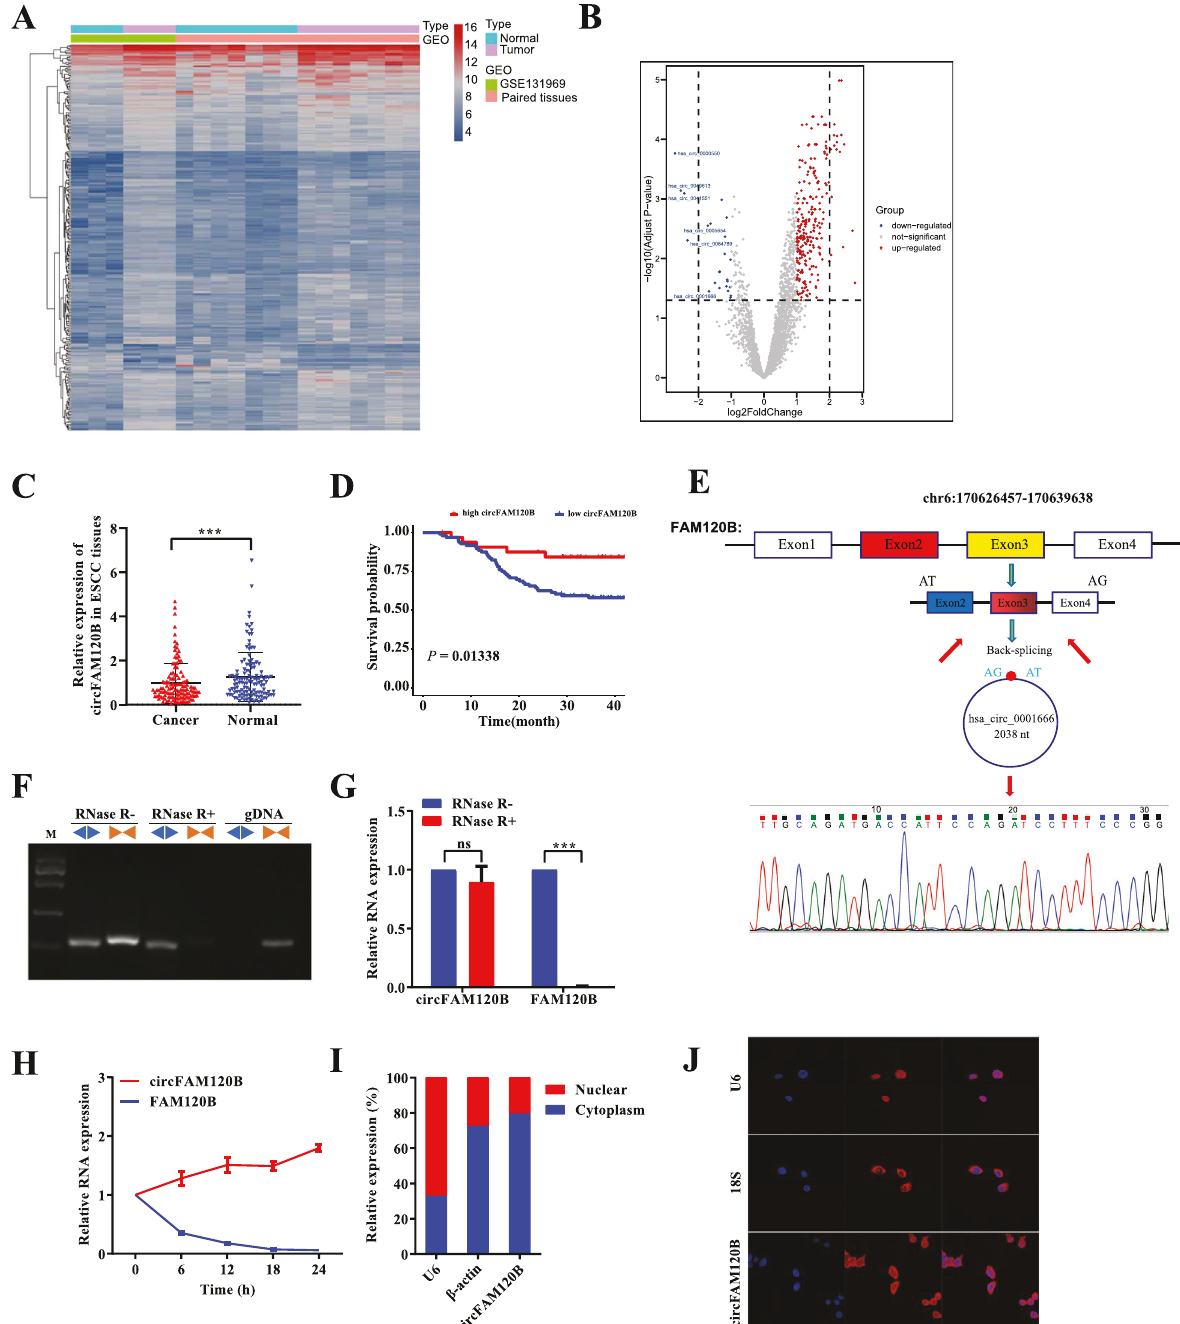
Fig. 1 Identi fi cation of circFAM120B as a circRNA in association with ESCC. A , B The heatmap and volcano plot showed 276 differentially expressed circRNAs in ten paired ESCC tissues by Arraystar Human Circular RNA Microarray. The cutoff value was |log 2 (FC)| > 1 & P adjust < 0.05. C Detection of circFAM120B in an additional 130 paired ESCC tissues by qRT-PCR analysis. D Kaplan – Meier analysis of ESCC patients based on circFAM120B expression ( n = 130). The upper quartile level of circFAM120B was de fi ned as the cutoff value. A log-rank test determined statistical signi fi cance. E The back-splice junction site of circFAM120B was con fi rmed by Sanger sequencing. F , G circFAM120B in cDNA and genomic DNA were analyzed by PCR and 2% agarose gel electrophoresis using divergent primers or convergent primers, respectively. H Changes in the abundance of circFAM120B and FAM120B were analyzed after treatment with actinomycin D (5 μ g/ml) at indicated time points. I Relative abundance of circFAM120B, β -actin, and U6 in the nuclear and cytoplasmic fractions of KYSE-150 cells was analyzed. J circFAM120B localization was analyzed by RNA FISH in KYSE-150 cells. *** P < 0.001. concluded that miR-661 had a positive effect on the malignant formation, and EdU assays, while miR-661 inhibitors remarkably phenotypes of ESCC. inhibited it (Fig. 3D – F). Transwell assays showed that miR-661 We searched three online tools for potential target genes of miR- mimics promoted the migration and invasion of ESCC cells, 661, including TargetScan (http://www.targetscan.org/mamm_31/), whereas miR-661 inhibitors restrained them (Fig. 3G). Hence, we Cell Death and Disease (2022)